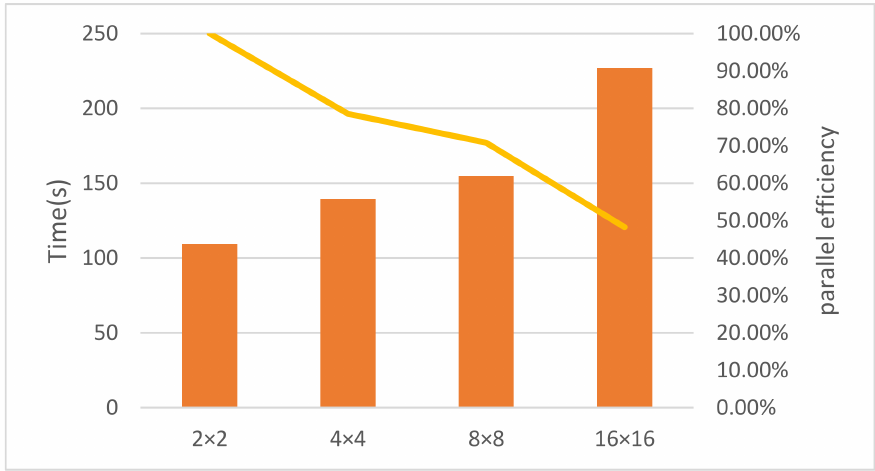
Figure 10. Unoptimized heterogeneous parallel weak scaling test.